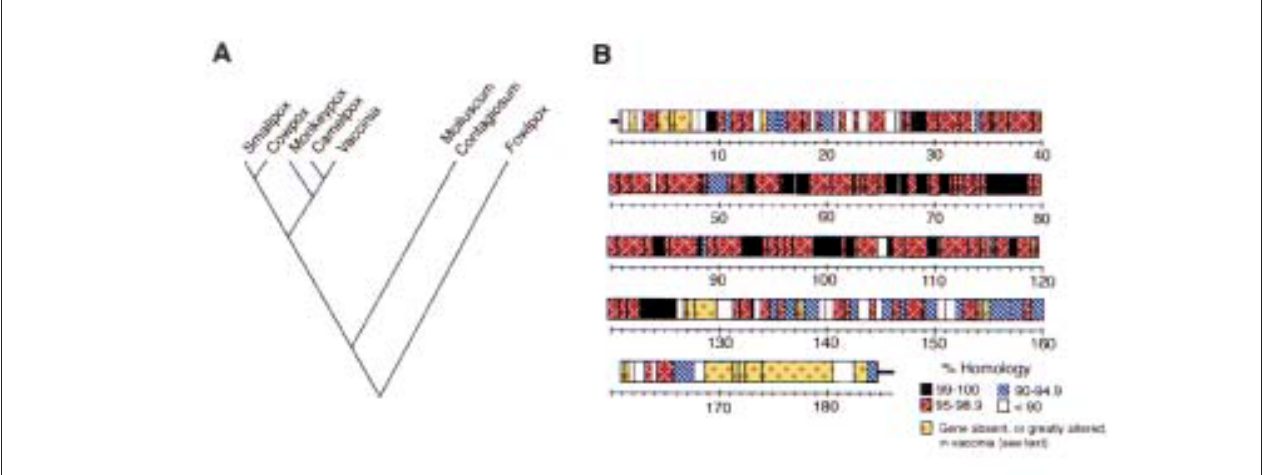
Figure 2) Genetic relatedness of selected poxviruses. Left ‘Low-resolution’ diagrammatic representation of relatedness of indicated viruses, based upon restriction fragment analyses (6,7) and partial sequence comparisons (8). Line lengths are arbitrary . Right Schematic comparisons of amino acid identity between vaccinia virus (10) and smallpox virus (11). The smallpox sequence is presented, and percentage homology of each predicted protein to the corresponding protein in vaccinia is indicated (11). Intervening noncoding regions are not shown. The scale line under the sequence indicates kilobases. Regions in the central portion of the smallpox genome share very high sequence homology (90% to 100%) to similar genes in vaccinia; however, regions present near both smallpox genomic termini share very little homology, are greatly altered or are absent from the vaccinia